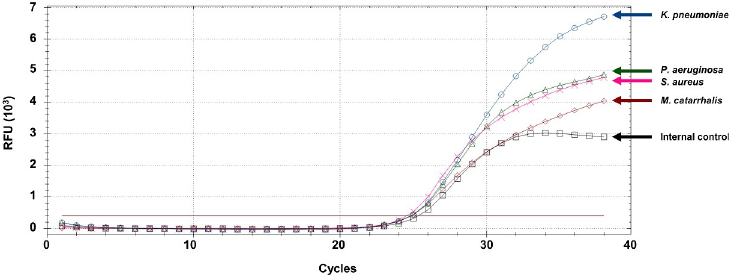
Fig 1. RB4 mRT-PCR assay performed using positive controls corresponding to Klebsiella pneumoniae , Pseudomonas aeruginosa , Staphylococcus aureus , Moraxella catarrhalis , and the internal control, respectively. The data were analyzed from cycle 1 to 38.